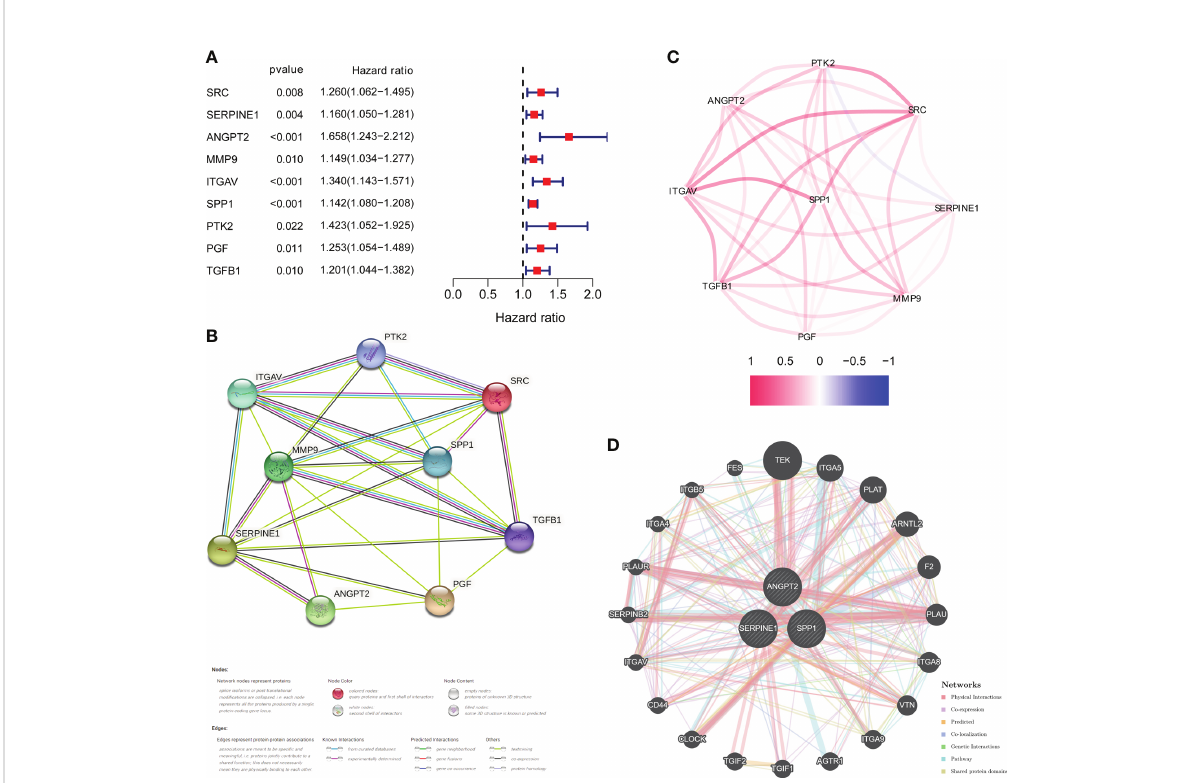
FIGURE 3 Identi fi cation of candidate genes related to the prognosis of HCC. (A) Forest plots of univariate Cox regression analysis of gene expression and OS in the TCGA cohort. (B) Protein – protein interaction (PPI) network and (C) correlated regulation network of prognostic HRAGs. (D) Correlation analysis of three model HRAGs from